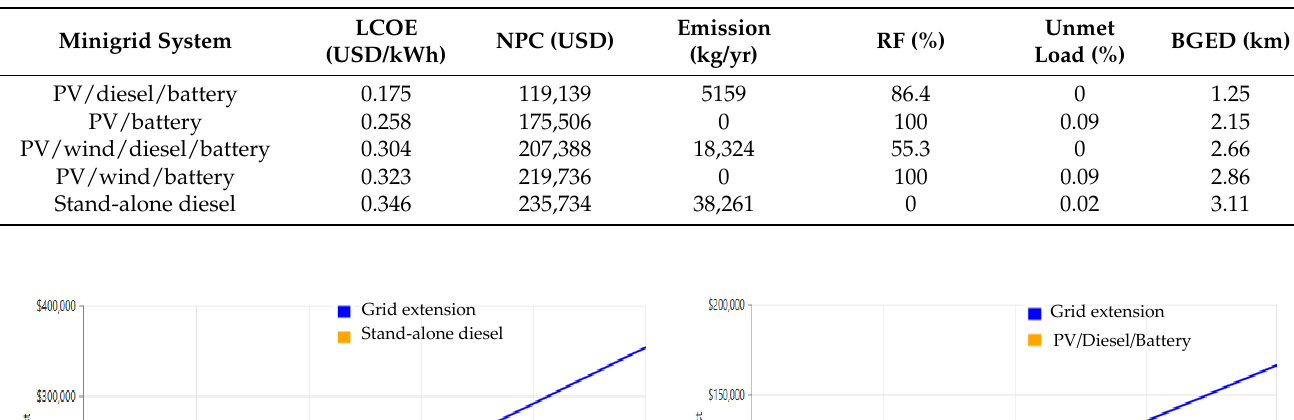
Table 3. Possible configurations for the selected site.